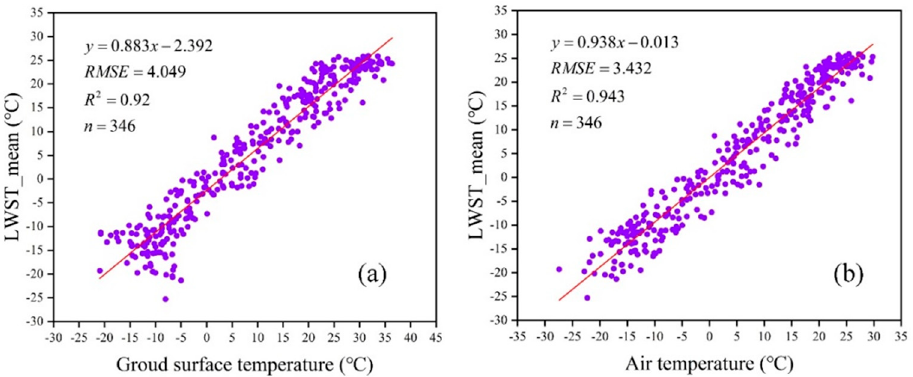
Figure 4. The comparison between climate records and MODIS-derived results in Chagan Lake.: ( a ) ground surface tem- perature (GST) vs. lake water surface temperature (LWST); ( b ) air temperature (AT) vs lake water surface temperature (LWST).